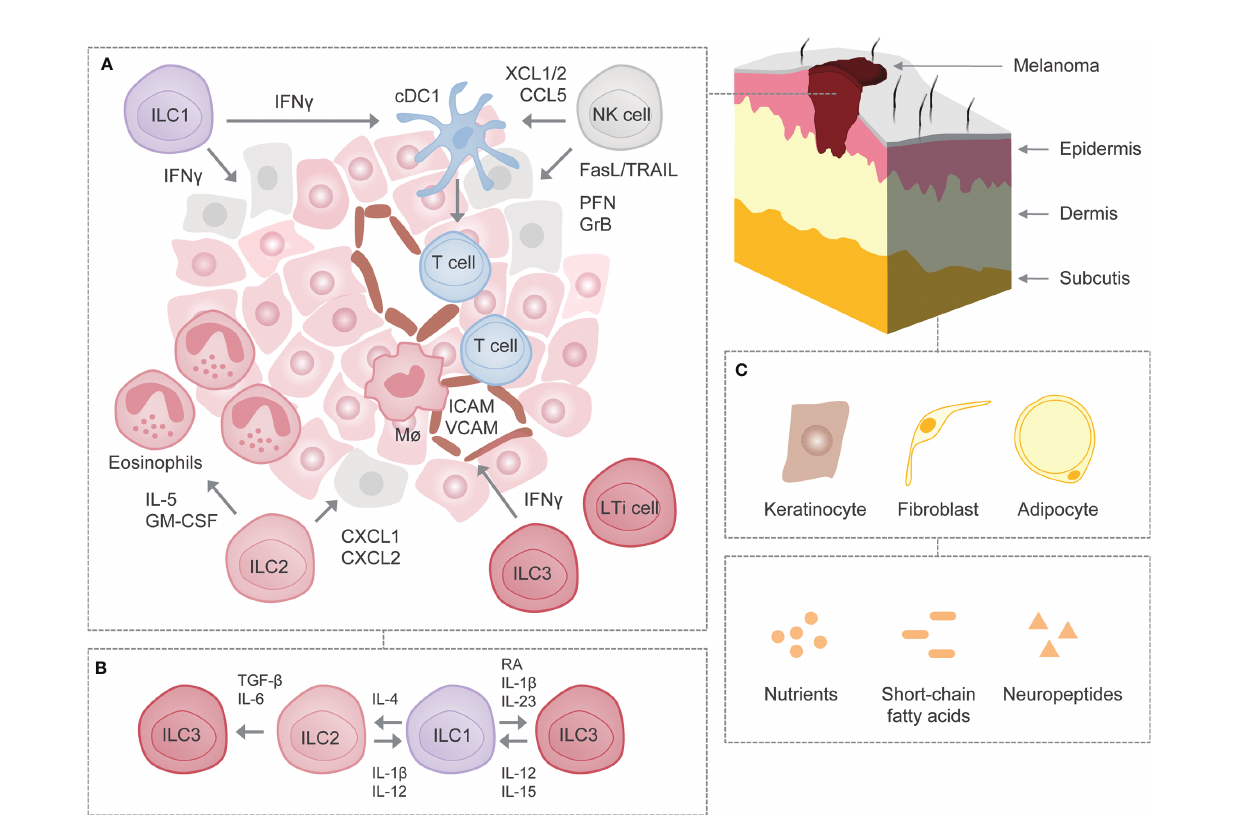
FIGURE 1 | ILCs in melanoma. (A) Schematic representation of cancer immunosurveillance by ILCs using mouse melanoma as a model. NK cells may induce apoptosis in melanoma cells through the release of cytotoxic granules containing perforin and granzyme B as well as through the engagement of death receptor- mediated pathways such as TRAIL and FasL. In addition, NK cells may recruit cDC1s to the tumor microenvironment by secreting XCL1/2 and CCL5 and may support their survival and maturation. ILC1s may produce IFN- g , which exhibits direct antitumor activity or modulates activity of other immune cells. On the other hand, ILC2s may attract and activate eosinophils through the production of IL-5 and GM-CSF. ILC2s may also induce tumor cell-speci fi c apoptosis via the release of CXCL1 and CXCL2. ILC3s may stimulate leukocyte recruitment to the tumor microenvironment through IFN- g -mediated upregulation of adhesion molecules ICAM and VCAM. (B) Plastic potential of ILCs. Following stimulation with certain cytokines, growth factors or metabolites, ILCs exhibit potential for plasticity, although it remains to be determined whether ILCs undergo such reversible transdifferentiation in melanoma. (C) Interactions with parenchymal cells as well as non-cytokine factors in the skin. It remains to be deciphered whether ILCs interact with certain parenchymal cells as well as non-cytokine factors known to affect the function of ILCs in other settings. FasL, Fas ligand; GrB, granzyme B; ICAM, intercellular adhesion molecule; M f , macrophage; PFN, perforin; RA, retinoic acid; TRAIL, TNF-related apoptosis-inducing ligand; VCAM, vascular cell adhesion